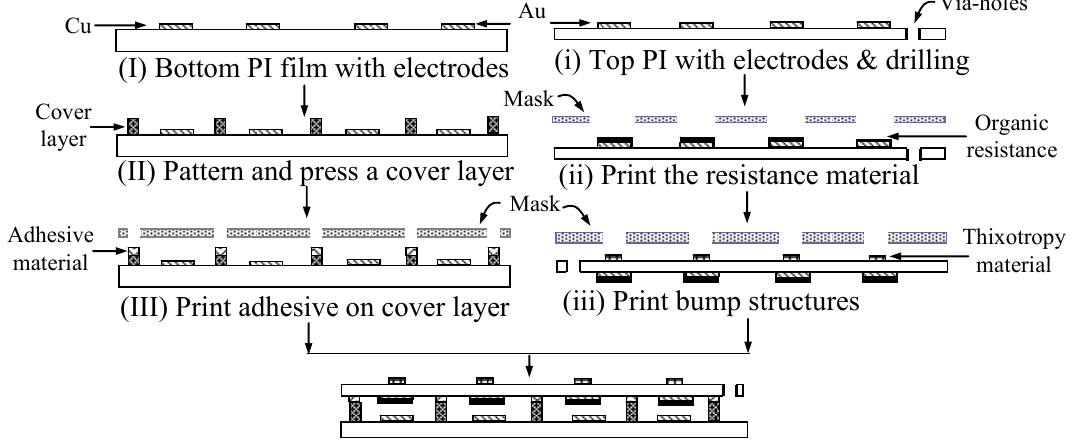
Figure 1. Fabrication procedures of flexible electronics sensors for large area manufacturing using screen printing